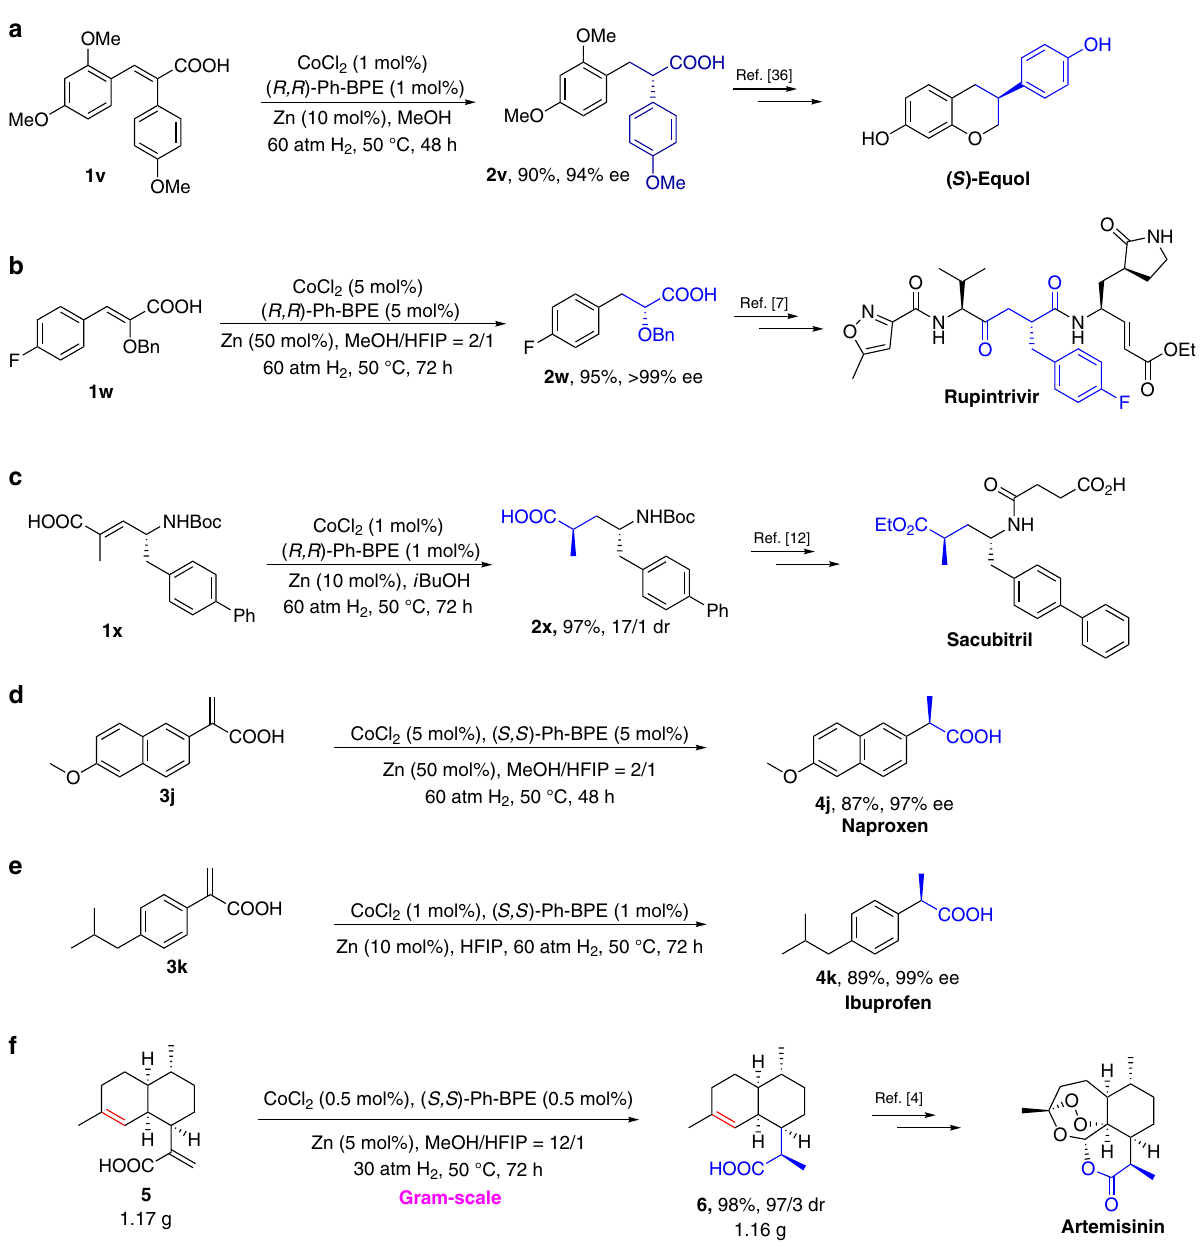
Fig. 5 Practical synthetic applications of cobalt-catalyzed asymmetric hydrogenation. a Synthesis of ( S )-Equol intermediate via cobalt-catalyzed hydrogenation. b Synthesis of Rupinnavir intermediate. c Synthesis of Sacubitril intermediate. d Asymmetric synthesis of Naproxen. e Asymmetric synthesis of Ibuprofen. f Gram-scale asymmetric hydrogenation of artemisinic acid 5